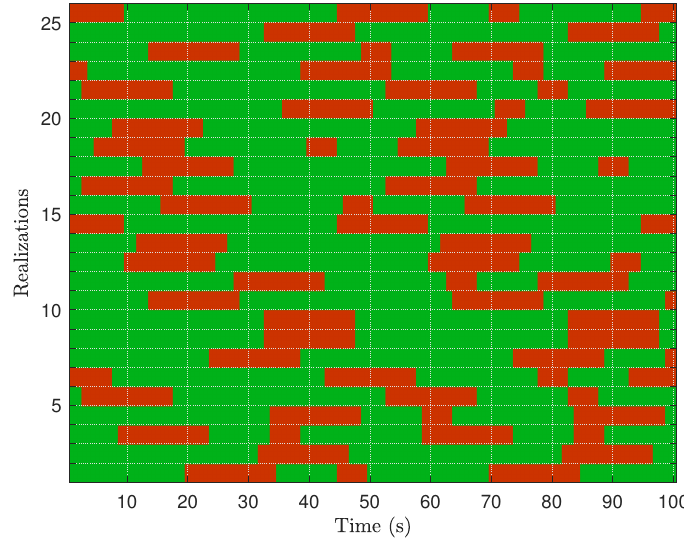
Figure 5. Signal green and red intervals for 25